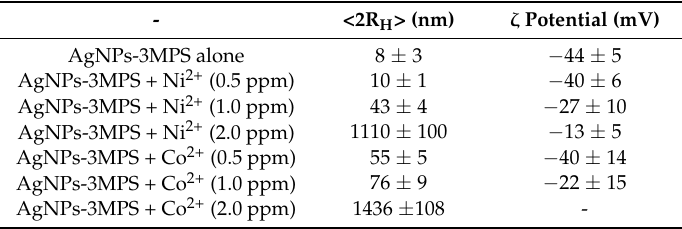
Table 1. Dynamic light scattering (DLS) measurements of AgNPs-3MPS before and after interaction with the ions–water solution at specific concentrations. In the table, the average diameter and the ζ potential are reported. Errors quote the standard deviation of at least three independent measurements.